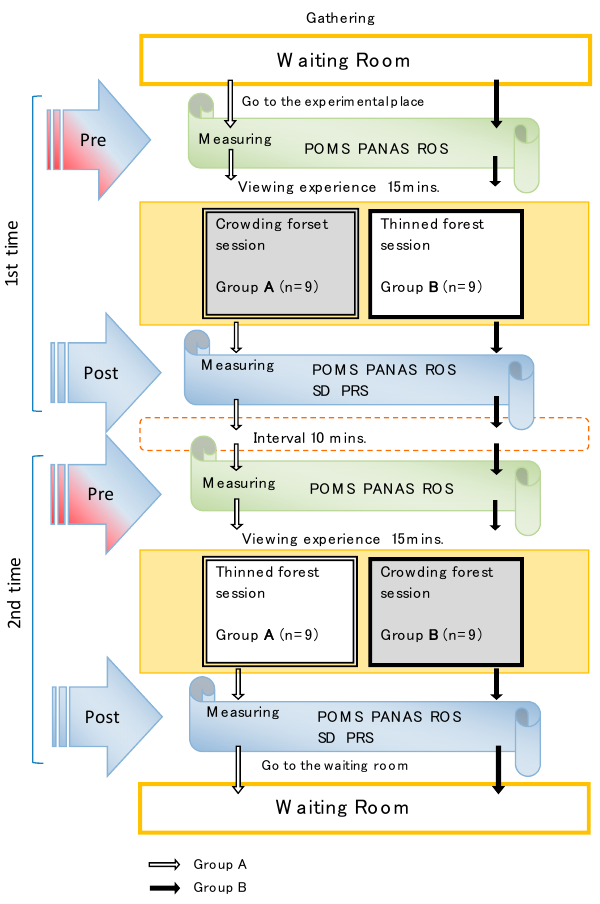
Figure 4. Experimental procedure. The same procedure was used in the both thinned and crowding forest sessions.